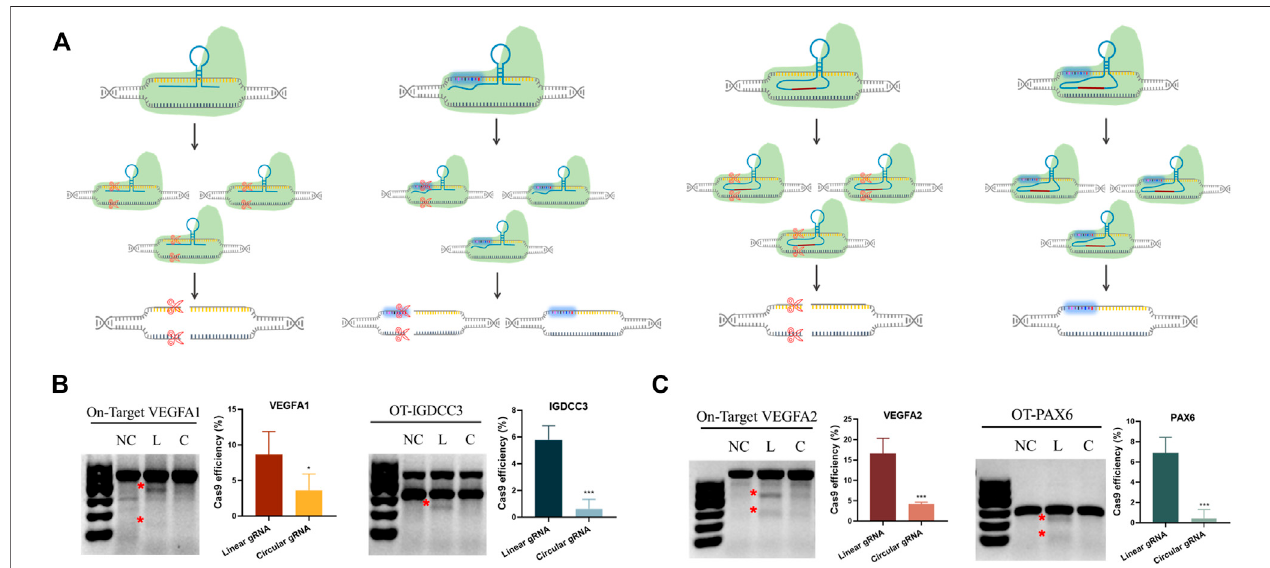
FIGURE 3 | Reduced CRISPR-Cas9 ef fi ciency and off-target rates in the circular gRNA compared to the linear gRNA. (A) A depiction of CRISPR-Cas9 targeted DNA cleavage under the guidance of linear and circular gRNA. The linear gRNA allowed ef fi cient on-target editing accompanied by some off-target events. The circulargRNA showed alower rateof on-target editing and the off-targeteventswerelargely abolished. (B,C) Therepresentativeresultsofthe T7E1 assay on the on- and off-target editing rates in linear and circular gRNA. Data were standardised to the no gRNA negative control group, and were presented as means ± SD from at least three independent experiments (* p < 0.05, *** p < 0.001).